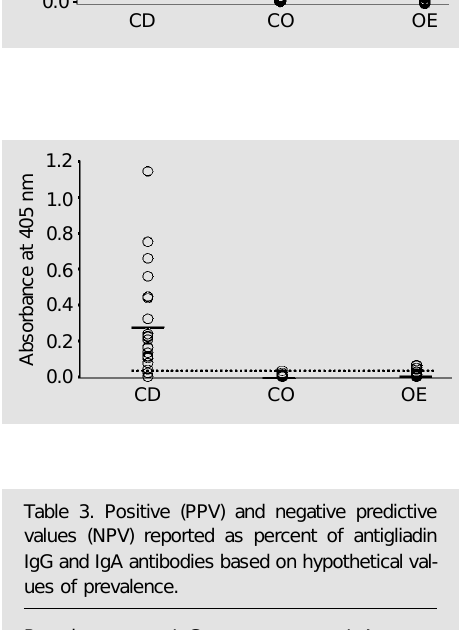
1. ELISA absorbance val- ues of antigliadin IgG antibodies in celiac disease (CD, N = 22), control (CO, N = 46) and other enteropathy (OE, N = 61) groups. The dotted line repre- sents the cutoff value. The solid lines represent the mean of the absorbance values for each group.